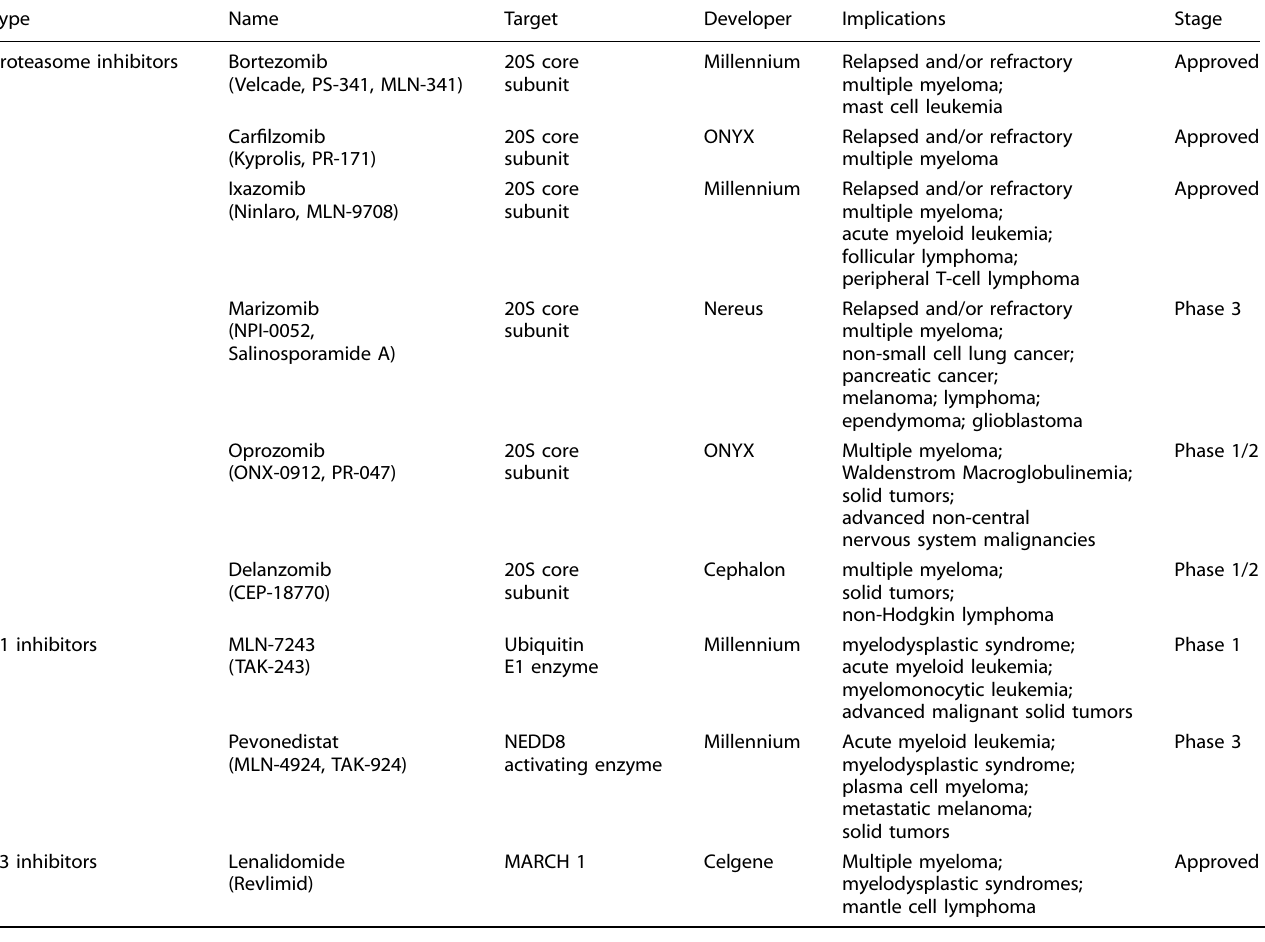
Table 3. Drugs that may regulate the immune checkpoint pathways through targeting ubiquitination/deubiquitination (clinical)